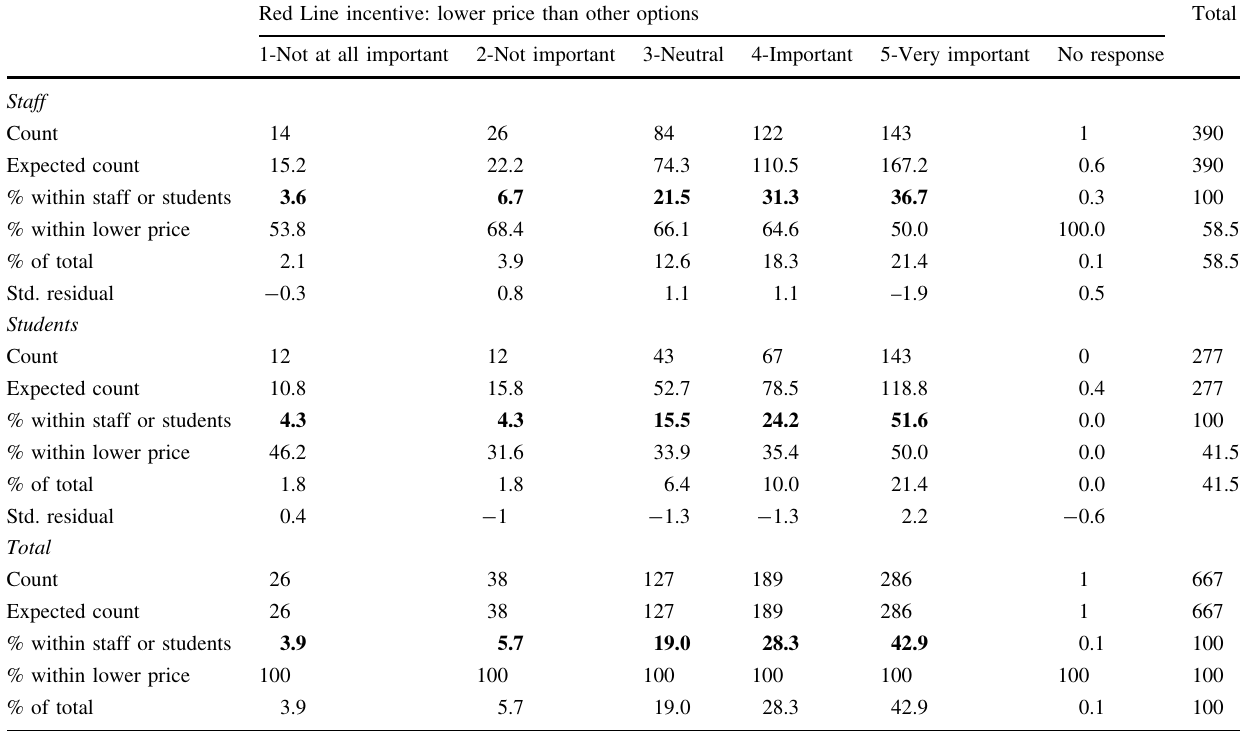
Table 6 Results for staff and students’ responses to the ‘lower price’ factor Red Line incentive: lower price than other